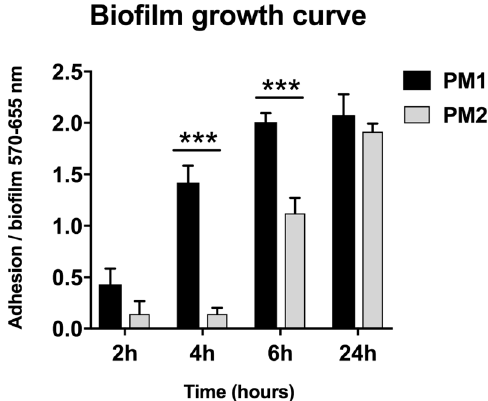
Figure 3. OD readings at 570–655 nm at various time points of biofilm growth of PM1 and PM2. Data are mean ± SD. Significant differences are indicated by *** p < 0.001 for comparison of PM1 vs. PM2.